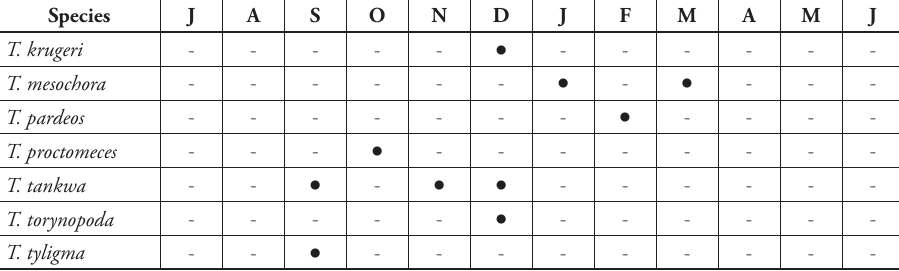
Table 1. Phenology of Trichoura species. Months commencing from July.